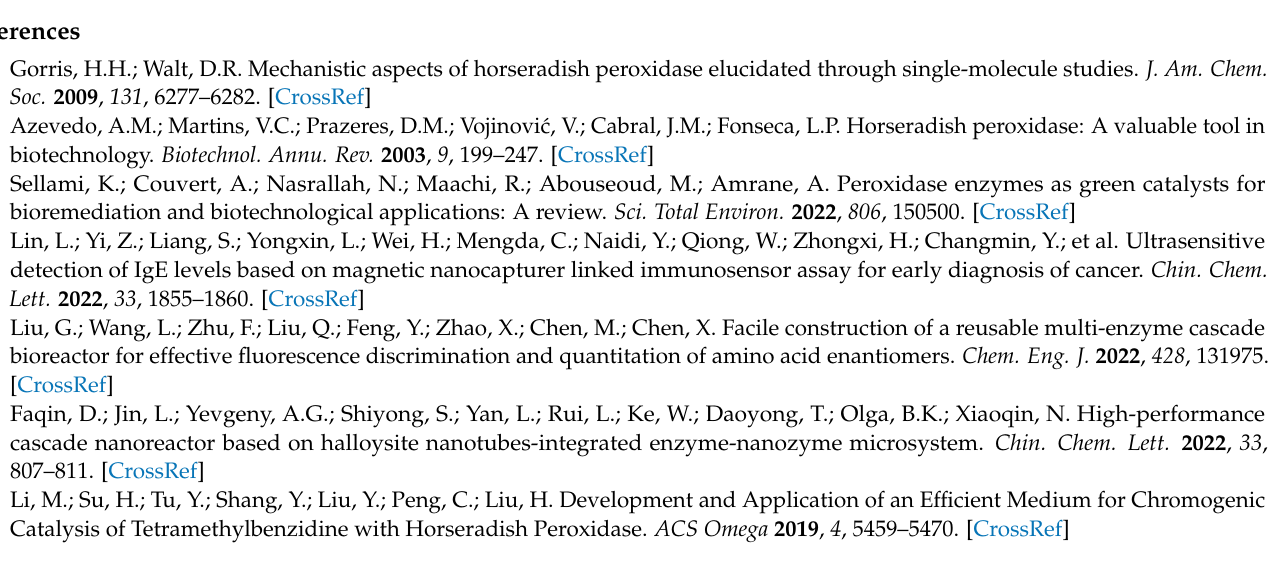
concentrations. Figure S5: UV–vis absorbance spectrum (a) and fluorescence spectrum (b) of Amplex red upon reaction with HRP/H 2 O 2 . The maximum intensity was normalized to 1 for easier compari- son. Figure S6: (a) The response kinetic curves of Amplex red upon reaction with HRP/H 2 O 2 under different pH conditions. (b) pH effects on the detection by DCFH-1 . Figure S7: Fluorescence images of the detection solutions by DCFH-1 (green color) and Amplex red (red color). The figure was captured by a smartphone camera. Figure S8: NO quantification from the cell culture medium [43]. The sample was diluted to match the detection range in case needed. Figures S9–S16: nMR spectra of the synthetic compounds. Equation (S1): the function for the calculation of relative